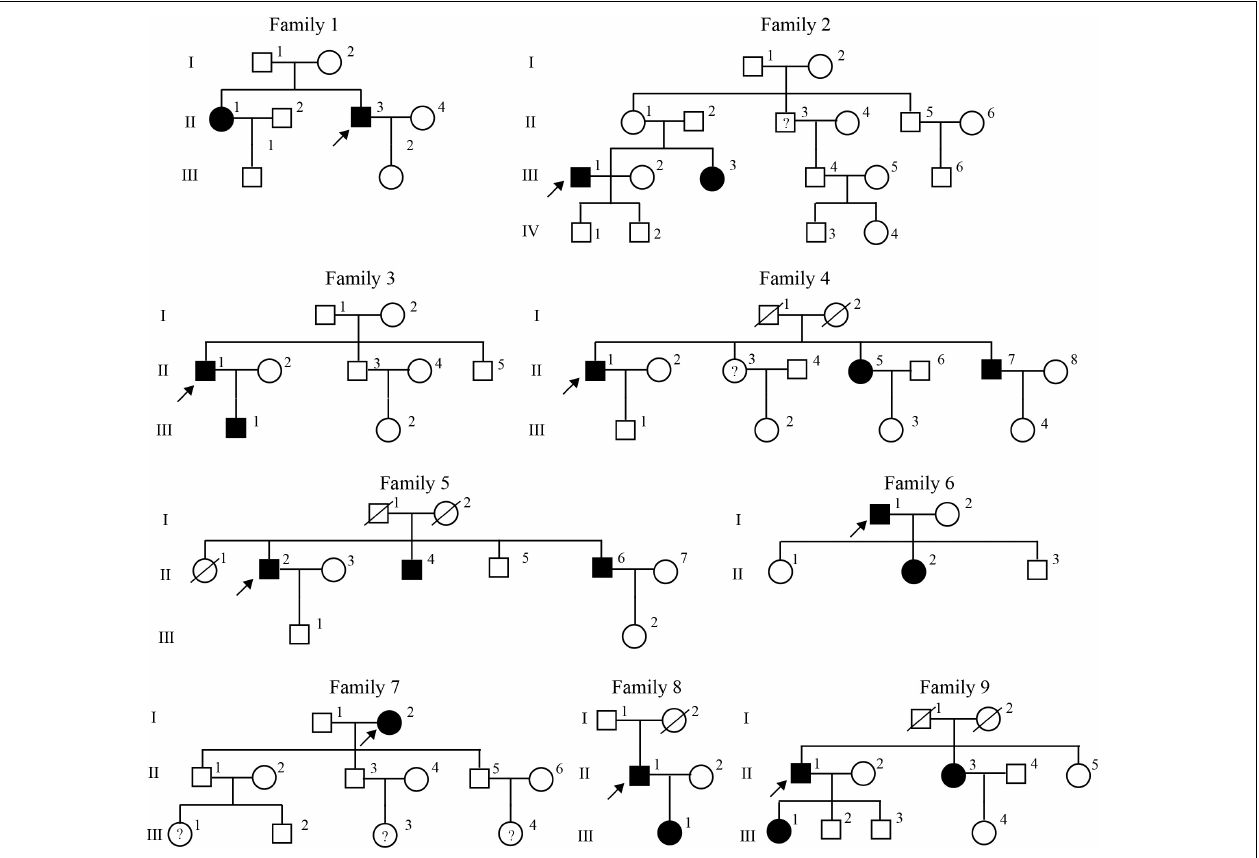
FIGURE 1 | Pedigrees of the nine families with familial atrioventricular nodal reentrant tachycardia. The open squares and circles indicate the normal male and female members, respectively. The filled squares and circles indicate the affected male and female members, respectively. Arrow denotes a proband, and WES investigated the affected individuals. Question mark (?) denotes clinically diagnosed PSVT.